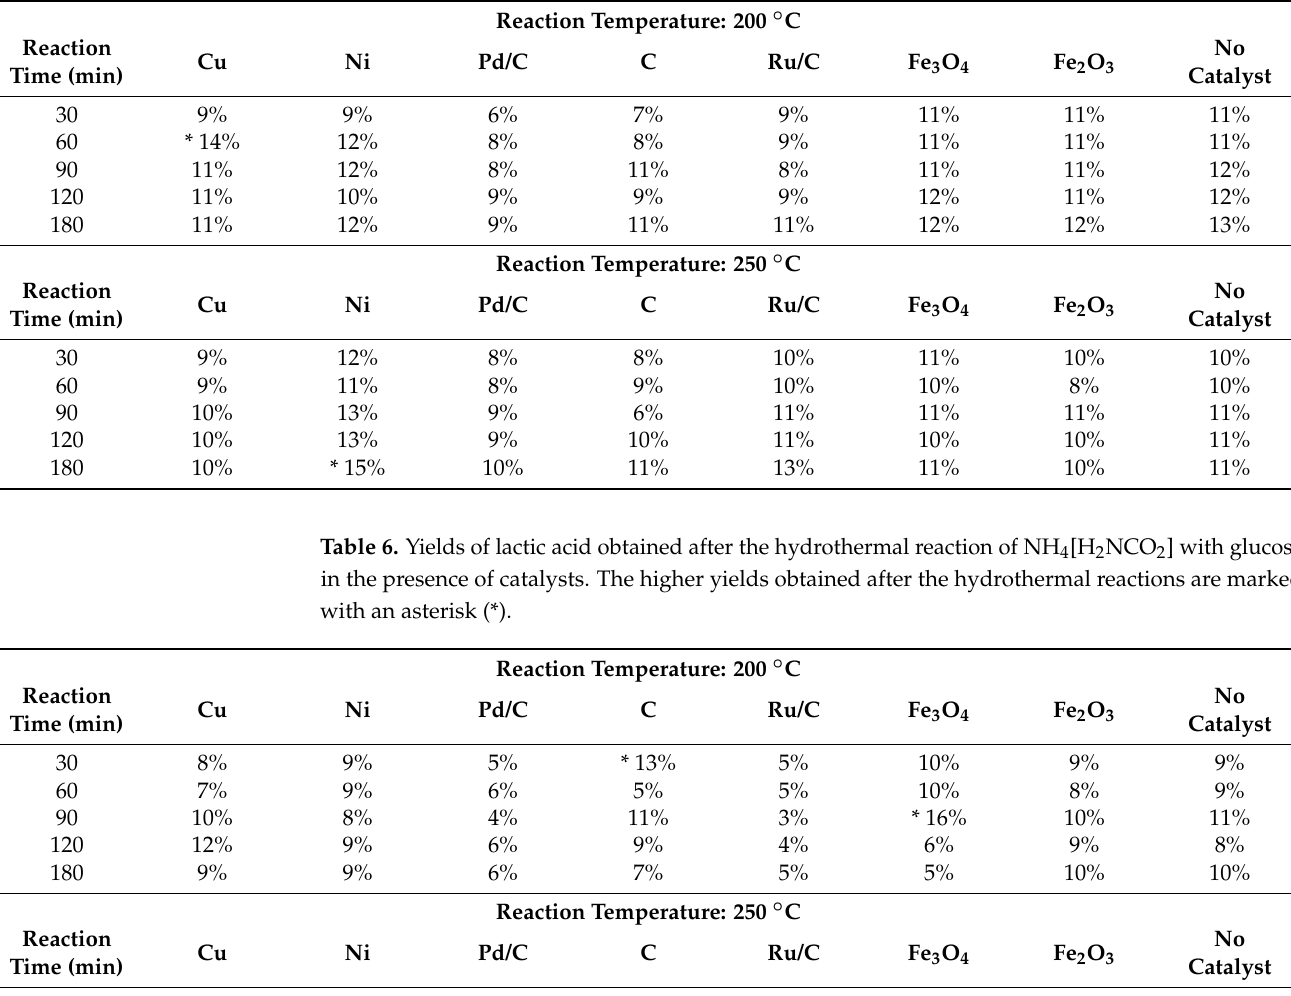
Table 5. Yields of acetic acid obtained after the hydrothermal reaction of NH 4 [H 2 NCO 2 ] with glucose in the presence of catalysts. The higher yields obtained after the hydrothermal reactions are marked with an asterisk (*).